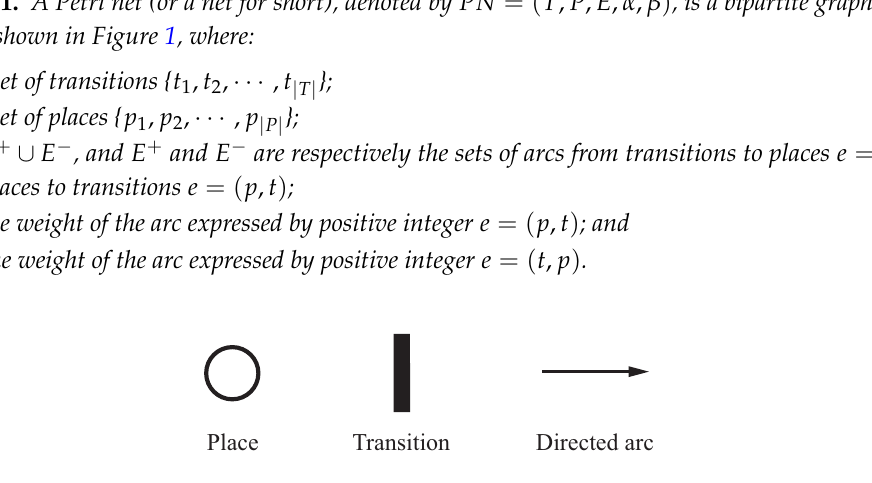
Figure 1. Petri net elements.